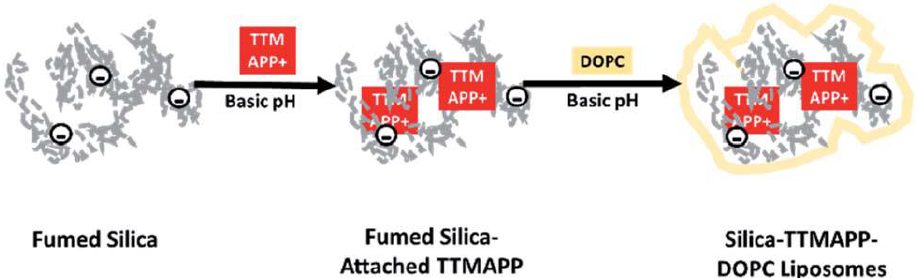
Figure 10. Formation of liposomes loaded with silica-attached TTMAPP porphyrin. Reprinted with permission from [138]. Copyright 2020 Royal Society of Chemistry.